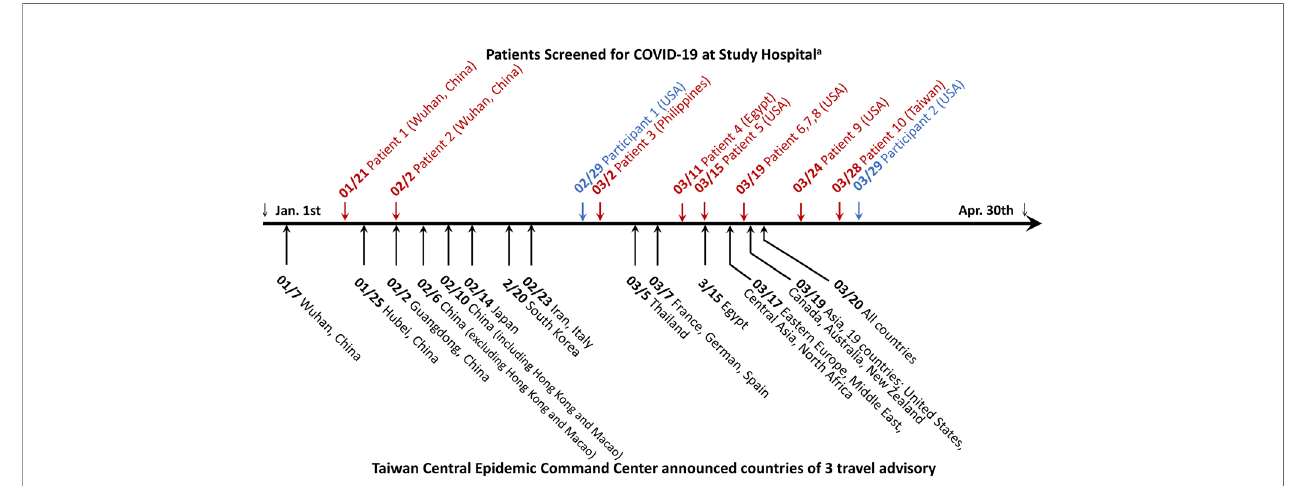
FIGURE 2 | Timeline of COVID-19 patient diagnosed at National Taiwan University Hospital and travel advisory announced by Taiwan Central Epidemic Command Center between January and April 2020. The diagnosis of COVID-19 was achieved either by a positive qRT-PCR testing result at initial screening visit in the emergency department or epidemic outpatient clinic (letters in red color) or retrospectively by serological test in this study (letters in blue color). The number-slash- number before COVID-19 patient denotes the latest date of leaving an area or country reporting COVID-19 outbreak for the 11 imported cases and the date of COVID-19 diagnosis for the one indigenous case. The city or country name indicates the travel location of the 11 imported cases, except one indigenous case who did not have travel history abroad.